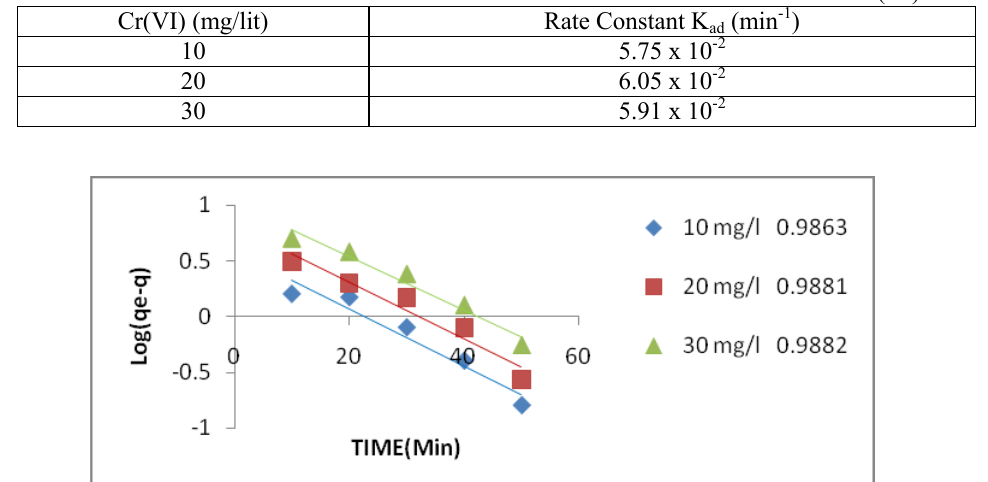
Figure7. Relationship between adsorption and time as per Lagergren